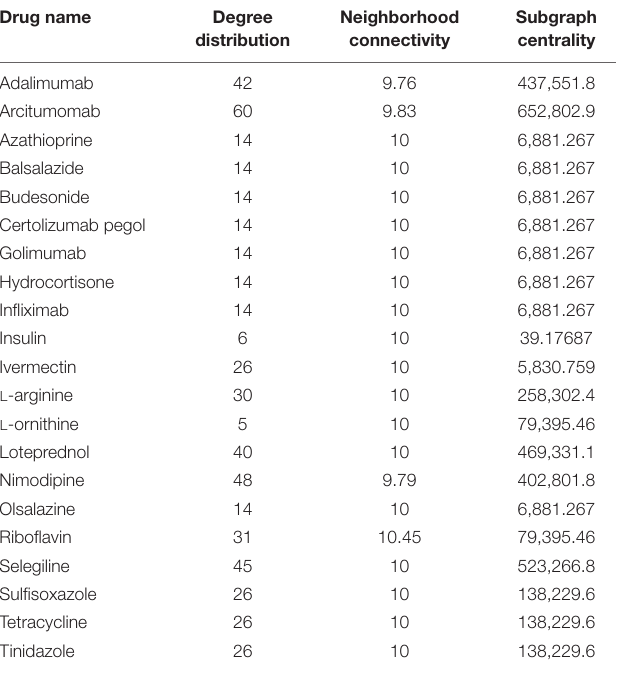
TABLE 6 | Network measures for possible drug treatments for muscle atrophy in spaceflight.